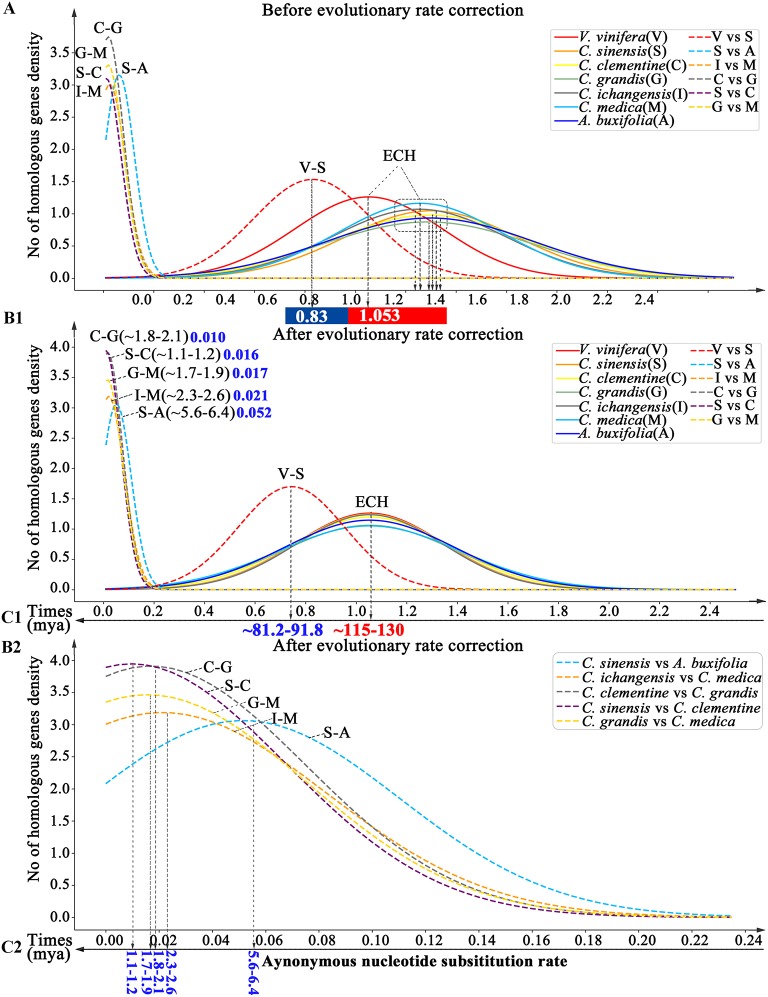
Dating evolutionary events within and among Rutaceae genomes. Distributions of Ks between intragenomic collinear genes are shown with solid curves and intergenomic ones with dashed curves. (A) Distributions before Ks correction. (B1,2) and (C1,2). Distributions of Ks after correction. Inferred times are shown beneath Time-axis.